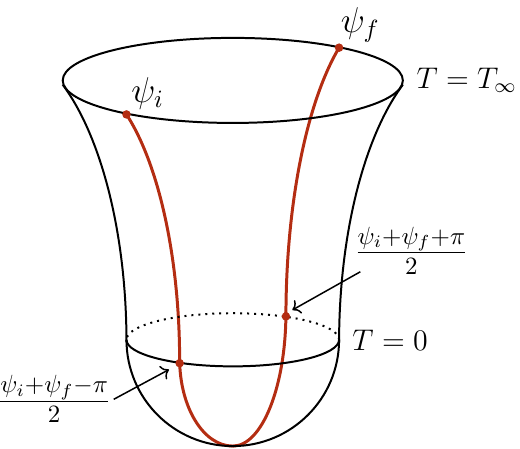
Figure 5 . The profile of a geodesic which connects two points on the future boundary in the Lorentzian dS 3 with an initial Euclidean hemisphere, following from the standard Hartle-Hawking